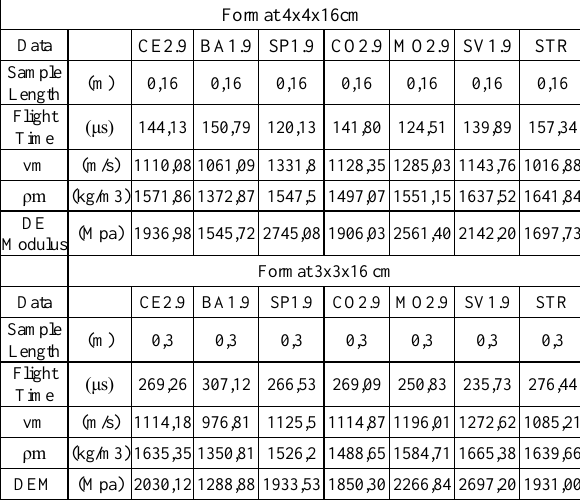
Table 6. Dynamic modulus of elasticity comparison, (where vm is the average propagation speed (m/s), ρm is the average density of the formulation (kg/m3). Produced by the authors.